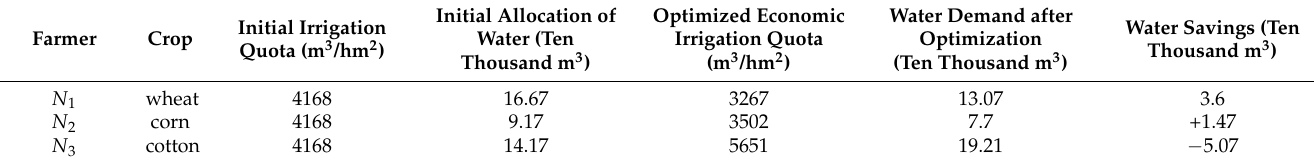
Table 3. Changes before and after optimization of irrigation quota among farmers.